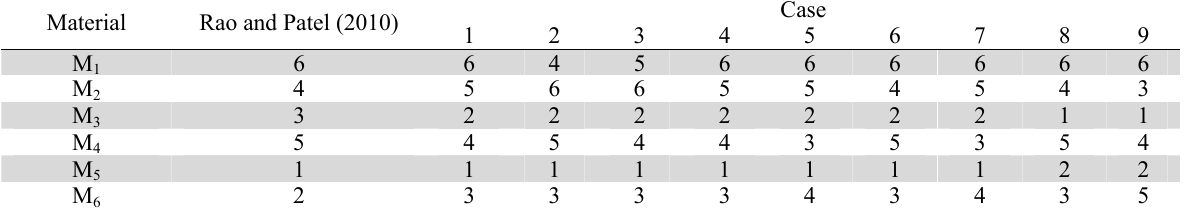
Rankings of high speed naval craft materials using PROMETHEE method Material Rao and Patel (2010)